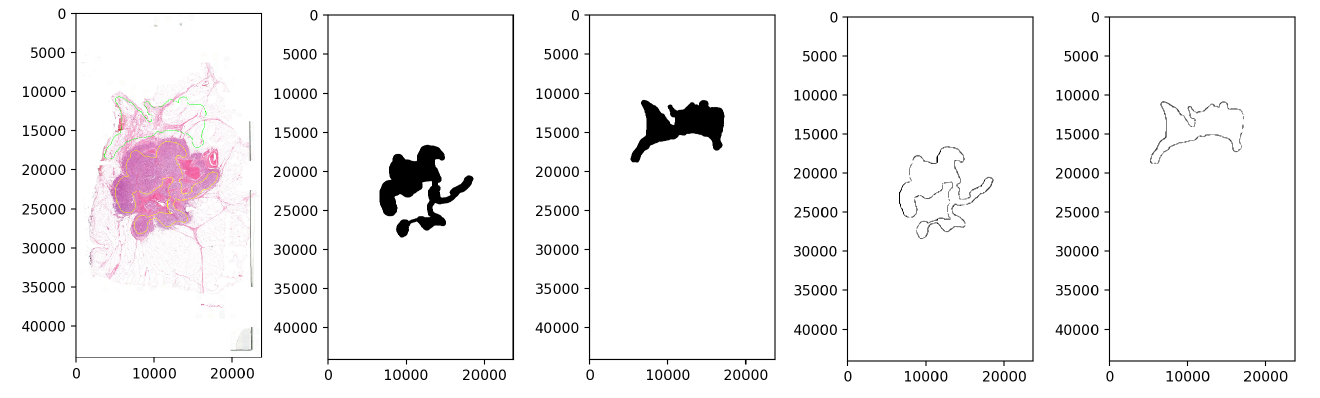
Figure 3. The process of masking the annotated areas (yellow: tumor, green: normal) and cutting out the inside patches of histopathological image regions.